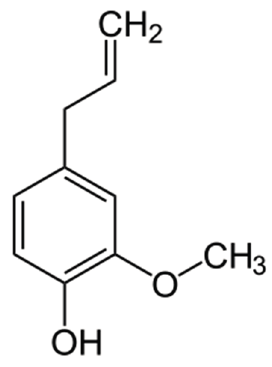
Figure 4. The chemical structure of eugenol